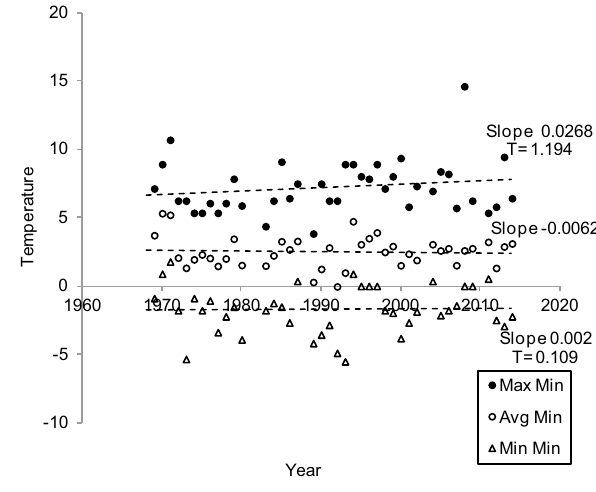
Slope 0.0268 T= 1.194